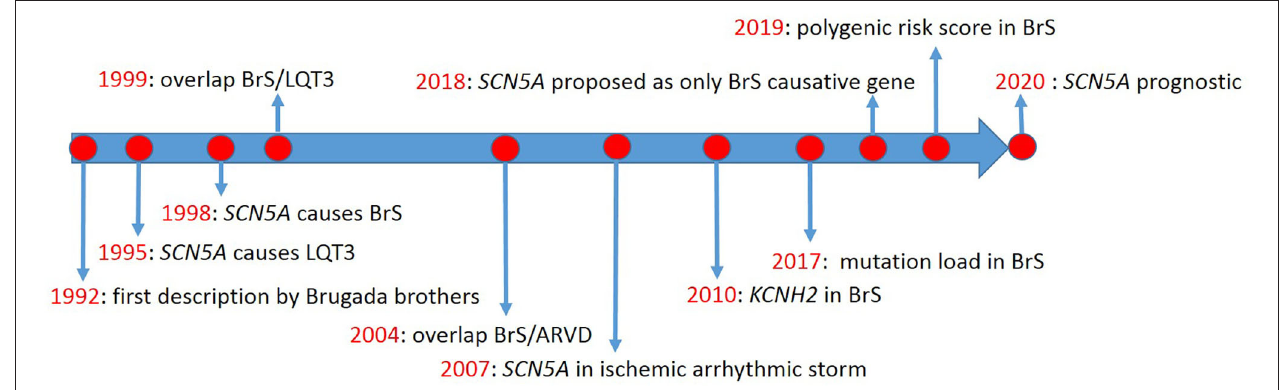
FIGURE 1 | Timeline of Brugada syndrome